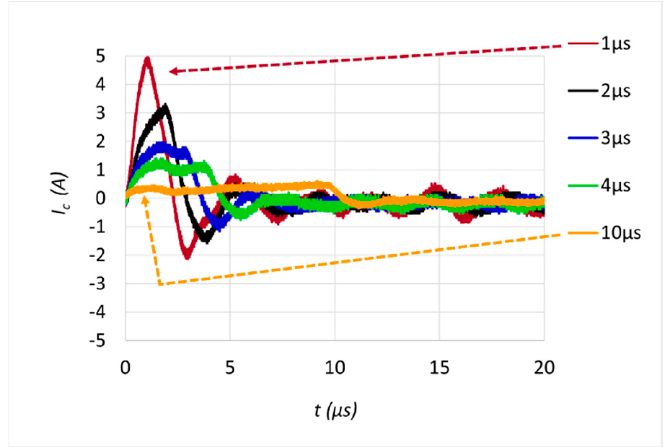
Figure 16. Measured transient current waveforms on the actuator.